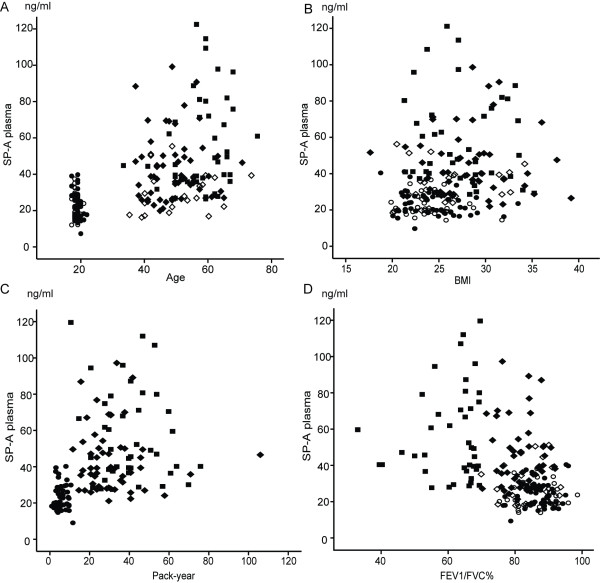
Relationship between plasma SP-A levels and the demographic parameters, age (A), BMI (B), pack-years (C) and FEV1/FVC% of predicted (D), in all of the subjects. ○ = young non-smokers; ● = young smokers; ◊ = middle aged/elderly non-smokers; ♦ = middle aged/elderly smokers; ■ = COPD patients.